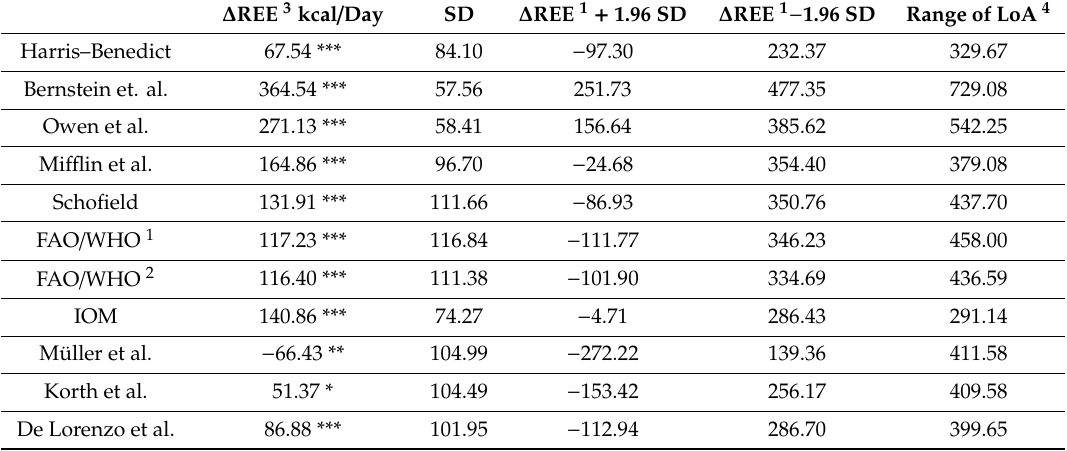
Figure 3. Individual consistency by the Bland-Altman method. 1 FAO / WHO—for weight only. 2 FAO / WHO—for weight and height. Table 4. Means and standard deviations (SD) of mean di ff erences of the estimated and predicted REE. ∆ REE 3 kcal /